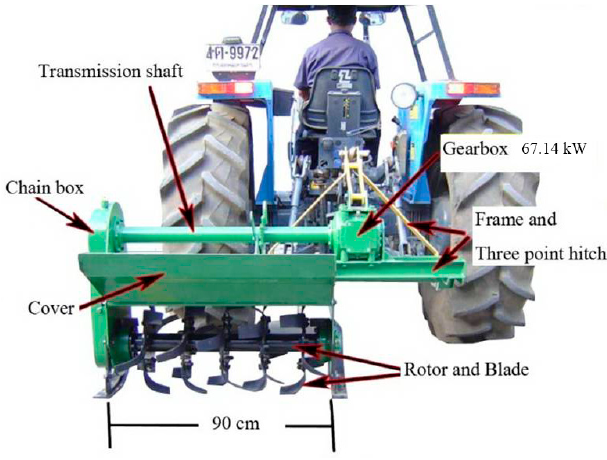
Figure 2. Prototype inter-row cultivator for mounting on a 63.4-kW tractor.